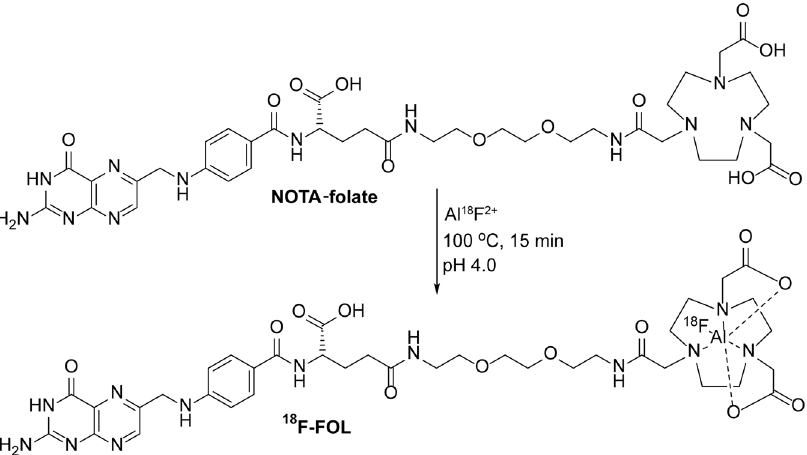
Figure 1. Radiosynthesis of 18 F-FOL. In the structure of 18 F-FOL (molecular formula C 37 H 5018 FN 12 O 12 , calculated molecular weight 899.8615), the folic acid moiety is 424.3970 Da. The linker, chelator, and Al 18 F moieties are 475.4645 Da in total, and account for 53% of the molecular weight of 18